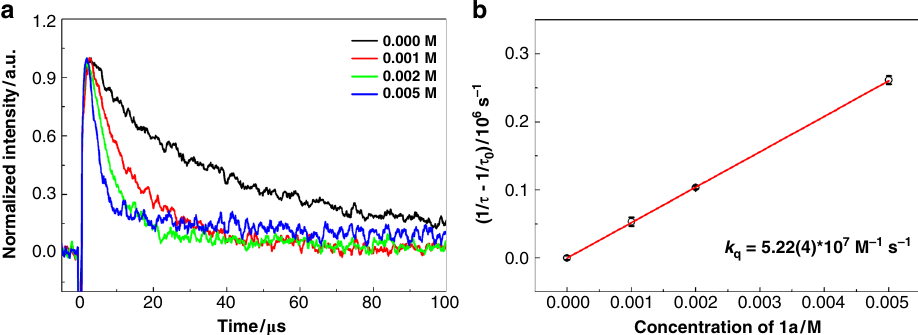
Fig. 5 Kinetic studies. a Decay of I at 400 nm at 25 °C with increasing concentrations of 1a from 0 M to 0.005 M. b Stern − Volmer plots generated from the fi tted lifetime of I in the presence of 1a in different concentrations at 25 °C